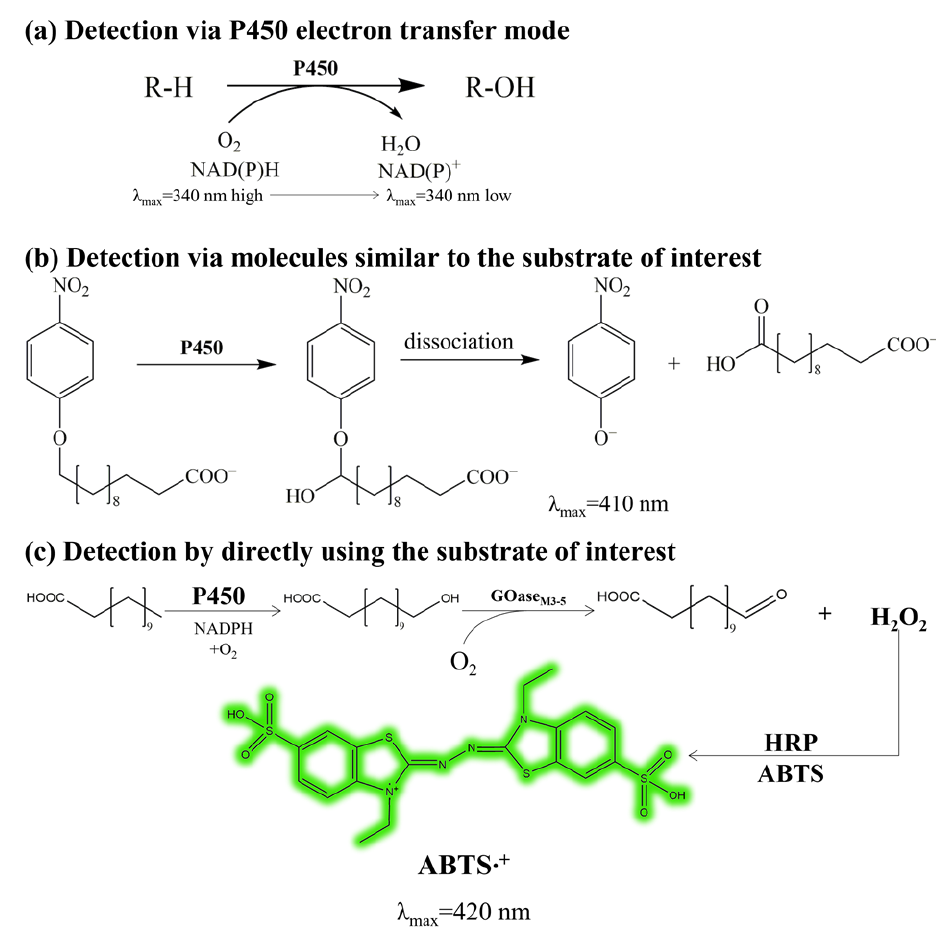
Figure 2. High-throughput screening (HTS) methods for P450. ( a ) Based on the P450 electron transfer mode, the P450 activity is assayed by measuring the NAD(P)H consumption. ( b ) Using ω -p- nitrophenoxycarboxylate acids (pNCA) as the artificial substrate, the terminal hydroxylation activity of P450 is assayed by measuring the yellow p-nitrophenoxy ions generated upon the dissociation of the product. ( c ) Using a mutant of galactose oxidase (GOase M3-5 ) with the specific oxidation activity of terminal fatty acid hydroxylates, the terminal hydroxylation activity of P450 could be assayed by quantifying the actual product ω -OHDDA via measuring the H 2 O 2 generated during its oxidation to aldehyde by GOase M3-5 . The colorimetric measurement of H 2 O 2 is enabled by using horseradish peroxidase (HRP) and diammonium 2,2 (cid:48) -azino-bis(3-ethylbenzothiazoline-6-sulfonate) (ABTS). ABTS · + , the green–blue stable radical cationic chromophore formed by oxidation of ABTS. Fortunately, GOase M3-5 was much more sensitive to ω -OHDDA than D-glucose (Figure 3b). Using the absorbance of the buffer containing D-glucose as the background value, the result calculated by subtracting the background value from the absorbance value of the reaction product (I = max (I ω -OHDDA − I Buffer )) had a linear relationship with the concentration of ω -OHDDA in the range of 0.2–0.8 mM (Figure 3d). In this way, the false positive result caused by D-glucose in the system could be avoided. This modified HTS method was named ABTS 2.0